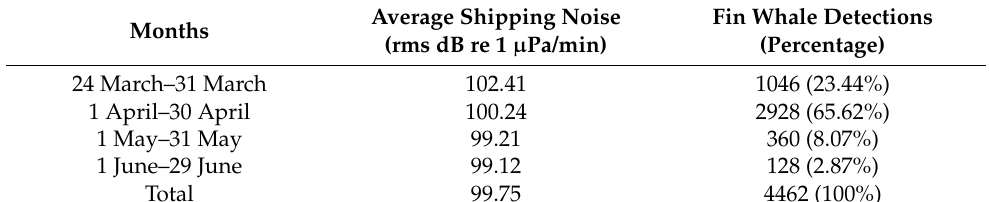
Table 3. Average rate of rms and average number of detections per species per month from March to June 2016.